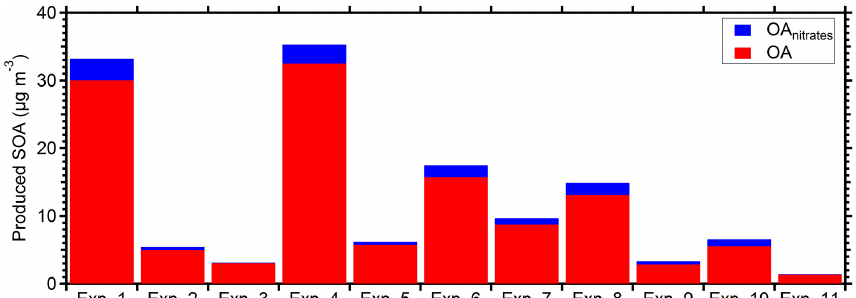
Figure 7. Produced OA (red bars) and the estimated organic nitrate (blue bars) in the perturbed chamber for the 11 perturbation experiments. All values have been corrected for wall losses and the AMS collection